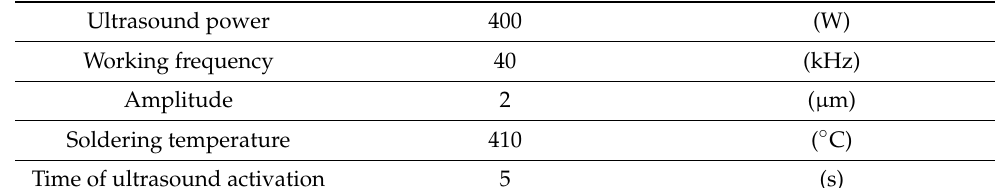
Table 2. Soldering parameters.